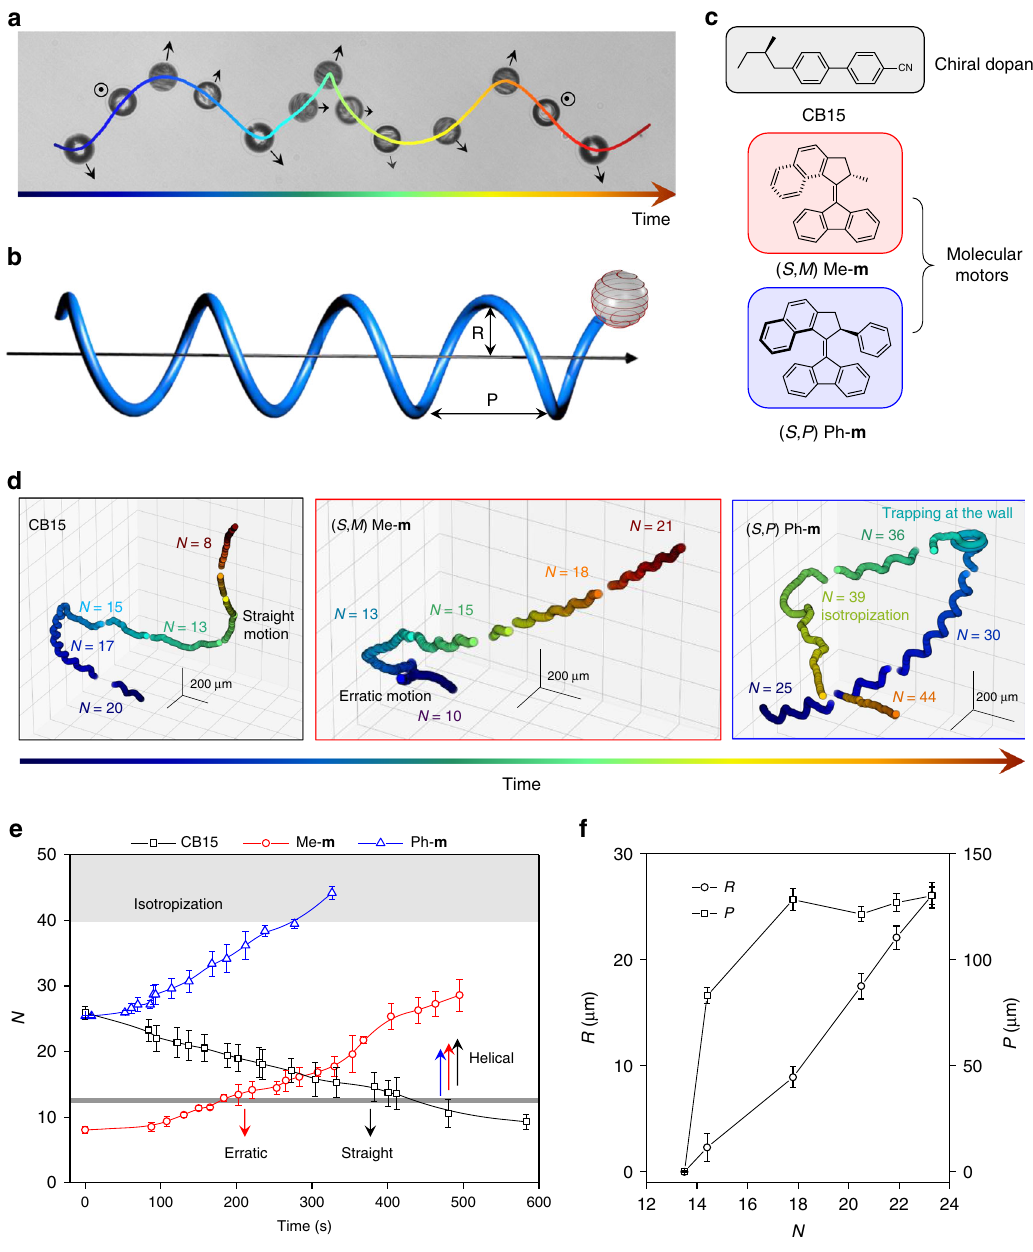
Fig. 2 Helical motion of spiral droplets. a Two-dimensional projection of the trajectory of a chiral droplet. The chirality of the droplet is expressed as a spiral pattern and the axis of the droplet (indicated by a black arrow) undergoes a precession along its helical trajectory. The data acquisition is done by manual z-tracking. b Representation of a left-handed droplet moving along a right-handed helical trajectory. The geometry of the motion is characterized by its radius R and pitch P. c Chiral molecules used as dopants to induce a cholesteric liquid crystal. CB15 is an enantiomerically pure chiral molecule. Me- m and Ph- m are molecular motors that modify the pitch of the liquid crystal helix and invert its handedness upon illumination. Ph- m induces larger twists than Me- m . d Complete trajectories for chiral droplets doped with CB15 (left), Me- m (center), and Ph- m (right). e Evolution of the con fi nement ratio N in time (number of spiral turns on the surface of the droplet), for droplets incorporating chiral dopant CB15 (black square, initial pitch is 1.5 μ m), Me- m (red circles, initial pitch is 4.3 μ m) and Ph- m (blue triangle, initial pitch is 1.6 μ m). In the case of Me- m and Ph- m , the concentration of dopant increases over time and eventually the droplet becomes isotropic. The solid lines are guides for the eye. The data are ensemble averaged and error bars correspond to the standard deviation. f Dependence of radius R (circles) and pitch P (squares) from the chirality con fi nement N . The error bars correspond to standard deviation. The data are ensemble averaged for six droplets doped with